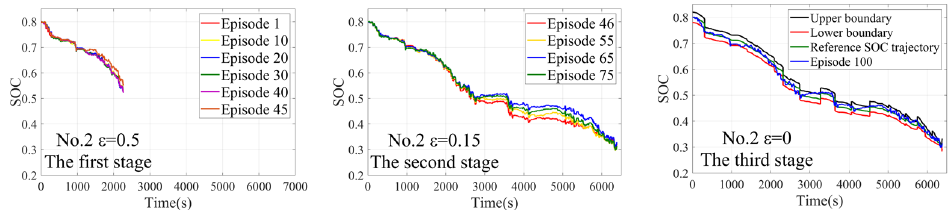
Figure 11. The training process of combined driving cycle 2.